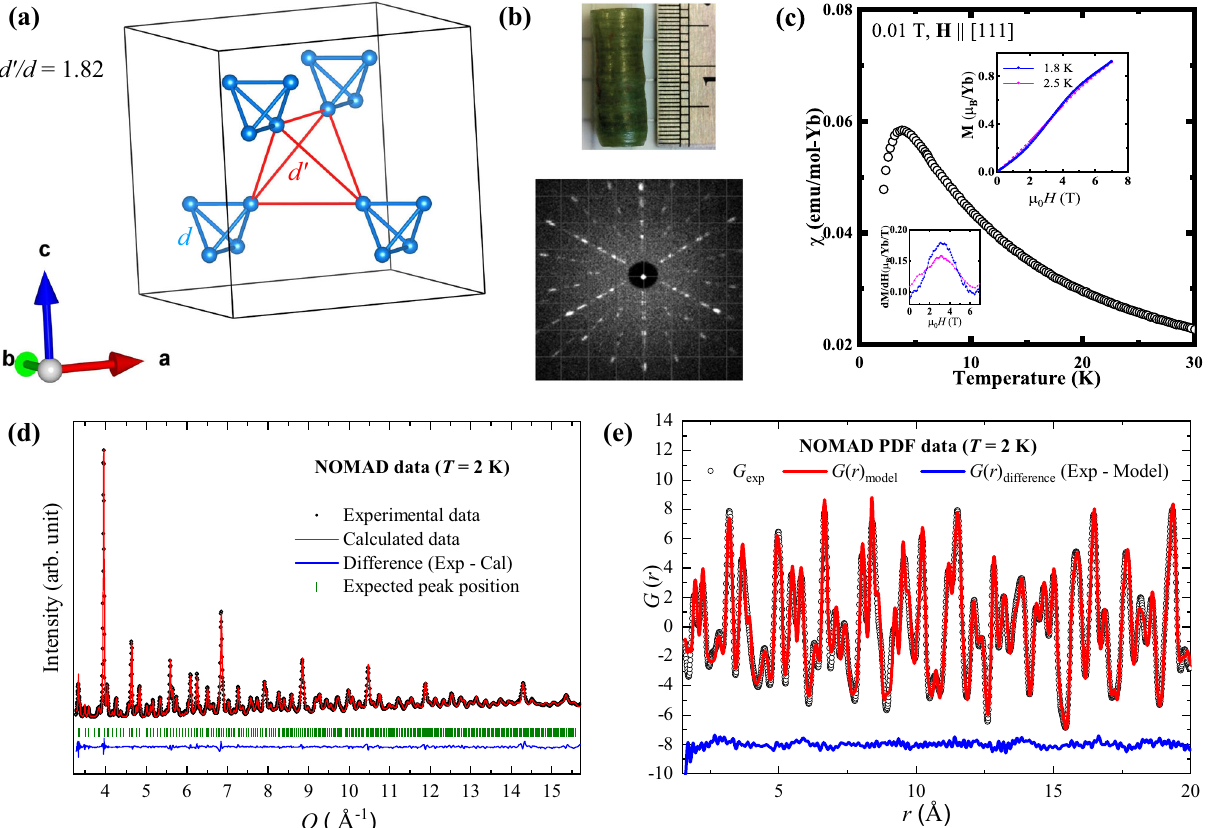
Fig. 1 Structural details and characterization of the single crystal. a The crystal structure of Ba 3 Yb 2 Zn 5 O 11 . b Single-crystal sample of Ba 3 Yb 2 Zn 5 O 11 used for single-crystal neutron scattering experiment and the Laue back-scattering diffraction pattern of plane perpendicular to the [111] direction. c Magnetic susceptibility χ vs temperature, T , down to 1.8 K. (Upper Inset) Field-dependent magnetization M ( H ) at different temperatures T = 1.8 K (blue curve) and T = 2.5 K (red curve), with μ 0 H sweep rate of 0.03 T/min. The in fl exion point in the M vs H data corresponds to a transition from an approximate total spin S tot = 0 state to an approximate S tot = 1 state. (Lower Inset) First derivative of magnetization M ( H ) as function of fi eld H at temperatures of T = 1.8 K (blue curve) and T = 2.5 K (red curve). d The Rietveld re fi nement of the neutron powder diffraction pattern of Ba 3 Yb 2 Zn 5 O 11 at 2 K collected using NOMAD at the Spallation Neutron Source of ORNL. The red and blue solid lines represent the calculated intensity and the difference between observed and calculated intensities (weighted pro fi le R -factor 51 , R wp = 4.79%), while the short vertical green marks represent the expected Bragg peak positions. e The pair density function (PDF) data at 2 K along with the re fi nement is shown. Black open circles, red lines, and blue lines represent the PDF data, the re fi nement using the PDFGUI software 50 with assumed space group F 43 m and the difference between PDF data and re fi nement,